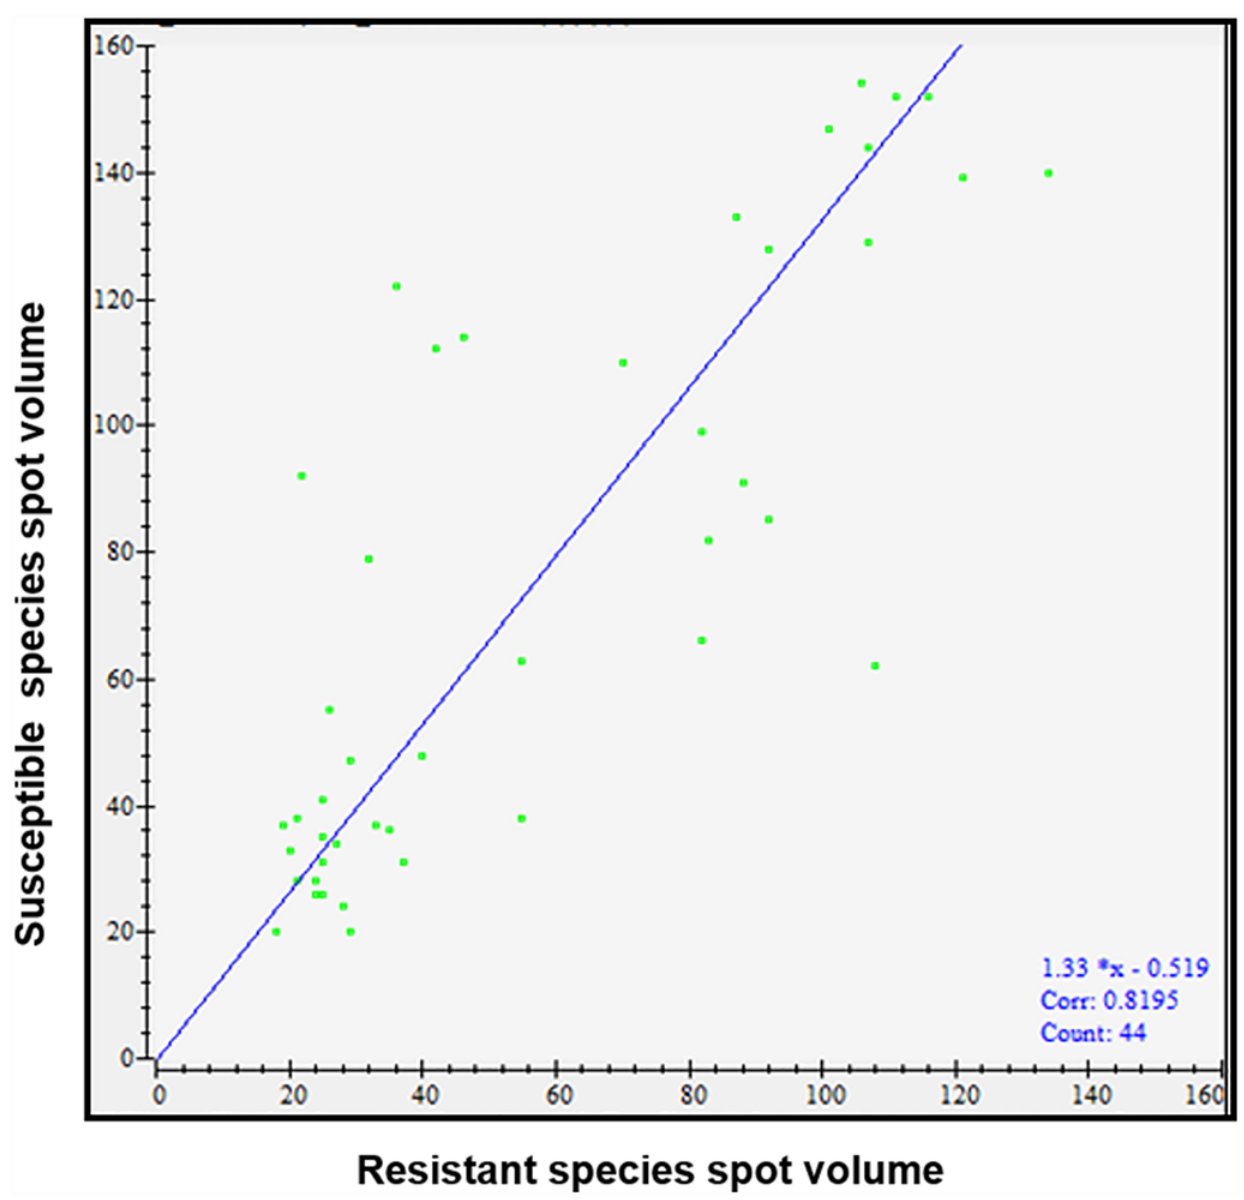
Fig 2. Scatter plot showing volume of all protein spots of An . stephensi salivary gland. Blue line shows linear regression. X axis represents the volumes of protein spots in An . stephensi susceptible species and Y axis represents volumes of protein spots in An . stephensi resistant species. Correlation coefficient was calculated and indicated at the